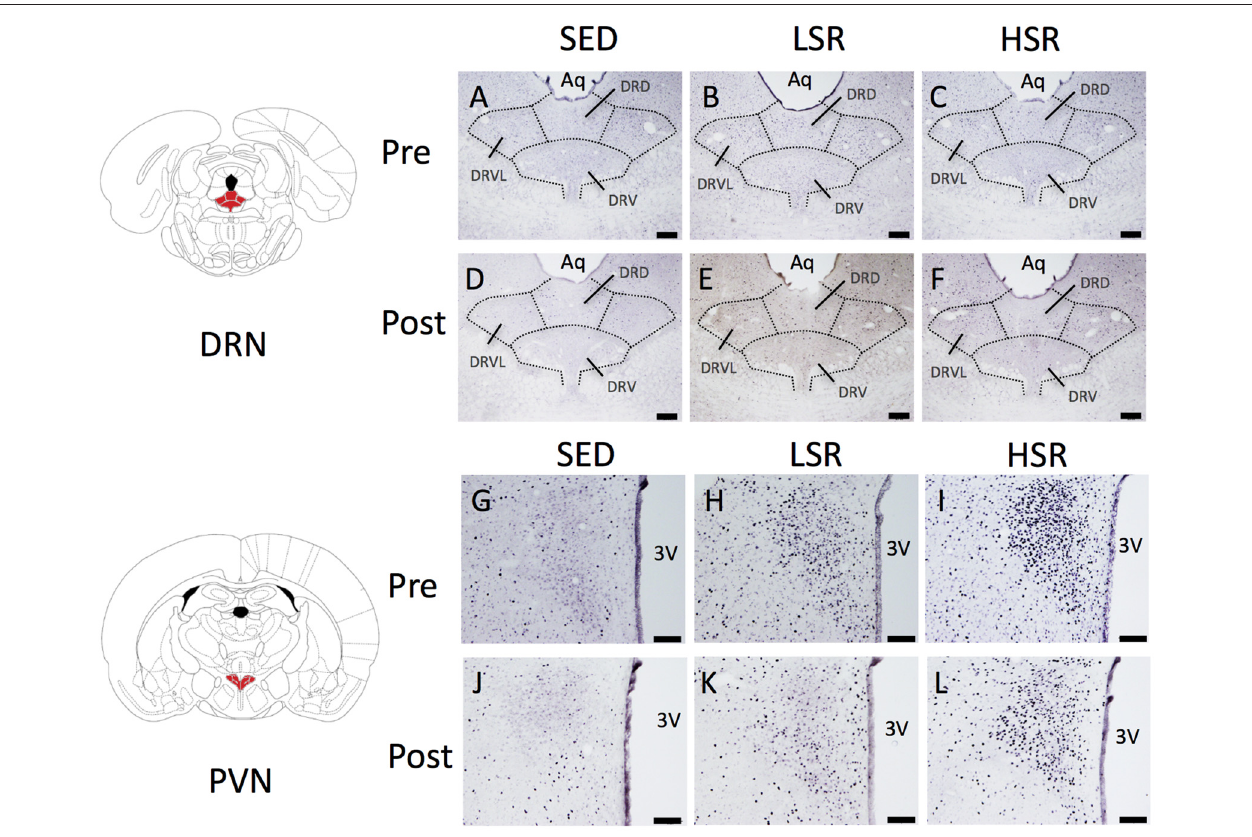
FIGURE 2 | Photographs of sections immunostained for c-Fos in the dorsal raphe nucleus (DRN; A–F ) and paraventricular nucleus (PVN; G–L ) of rats after acute treadmill running at different intensities in the pre- and post-training groups. Scale bars are 200 µ m (A–F) and 100 µ m (G–L) . Aq, cerebral aqueduct; DRD, dorsal raphe, dorsal part; DRV, dorsal raphe, ventral part; DRVL, dorsal raphe, ventrolateral part; 3V, 3rd